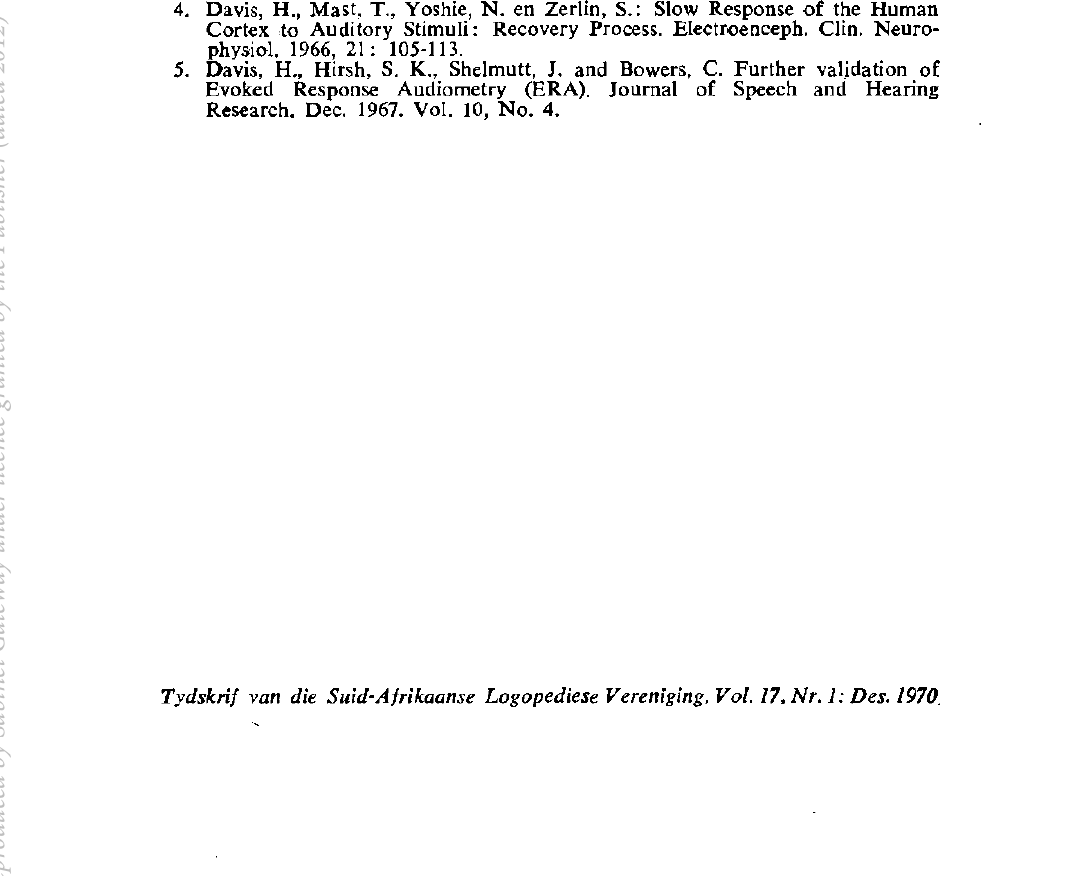
Tydskrif van die Suid-Afrikaanse Logopediese Vereniging, Vol. 17, Nr. 1: Des.